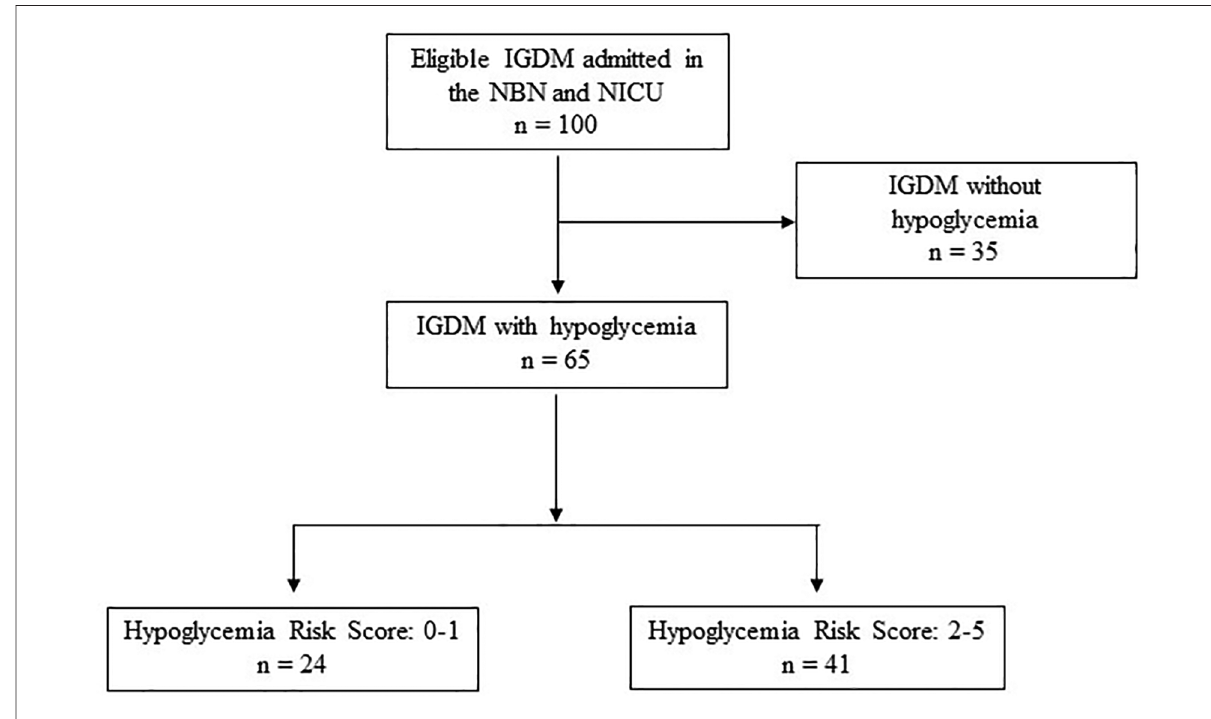
FIGURE 1 Flow diagram of study